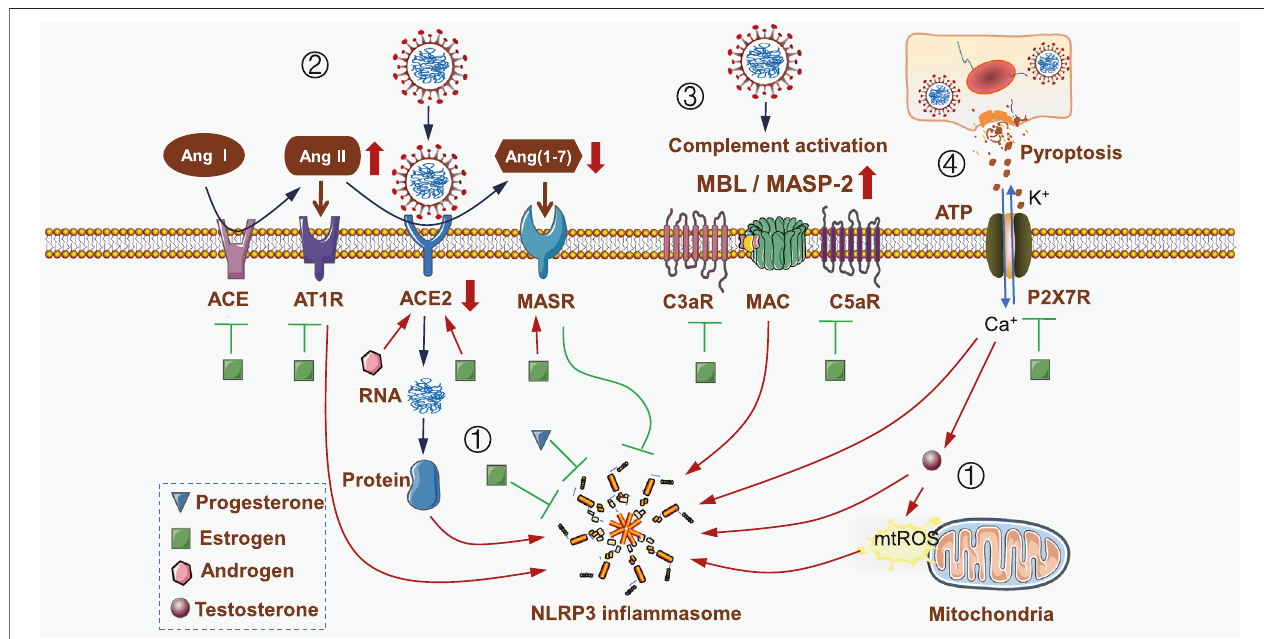
FIGURE 1 | Impact of sex differences on NLRP3 in fl ammasome activities during SARS-CoV-2 infection. (i) SARS-CoV-2 genome-encoded proteins directly activate NLRP3 in fl ammasome. Estrogen and progestin directly inhibit NLRP3 in fl ammasome. However, the increased level of testosterone during SARS-CoV-2 infection promotes NLRP3 in fl ammasome activation inaROS-dependent manner. (ii)SARS-CoV-2hijacksACE2 tomediate virus invasion and replication. ACE2 isthen downregulated, leading to a decrease in Ang (1 – 7) level, and ultimately weakens MASR-mediated inhibition of NLRP3 in fl ammasome; meanwhile, Ang II is upregulated and interacts with AT1R to activate NLRP3 in fl ammasome. Both androgen and estrogen inhibit NLRP3 in fl ammasome by increasing ACE2 expression. However, estrogen also inhibits ACE and ATR1, while upregulates MASR, thus leading to NLRP3 in fl ammasome inhibition. (iii) SARS-CoV-2 infection induces the activationofcomplementcascadebyincreasingthelevelsofMBL,MASP-2,C3aR,C5aRandMAC,whichinturnactivatesNLRP3in fl ammasome.Estrogeninhibitsthe activation of complement cascade to inhibit NLRP3 in fl ammasome. (iv) SARS-CoV-2 infection induces pyroptosis and releases extracellular ATP, which acts on P2X7R and results in an ionic fl ux to activate NLRP3 in fl ammasome; meanwhile testosterone is induced to activate NLRP3 in fl ammasome. Estrogen inhibits P2X7R, thus suppressing the activation of NLRP3 in fl ammasome. Triangle represents progesterone, square represents estrogen, hexagon represents androgen, and circle represents testosterone